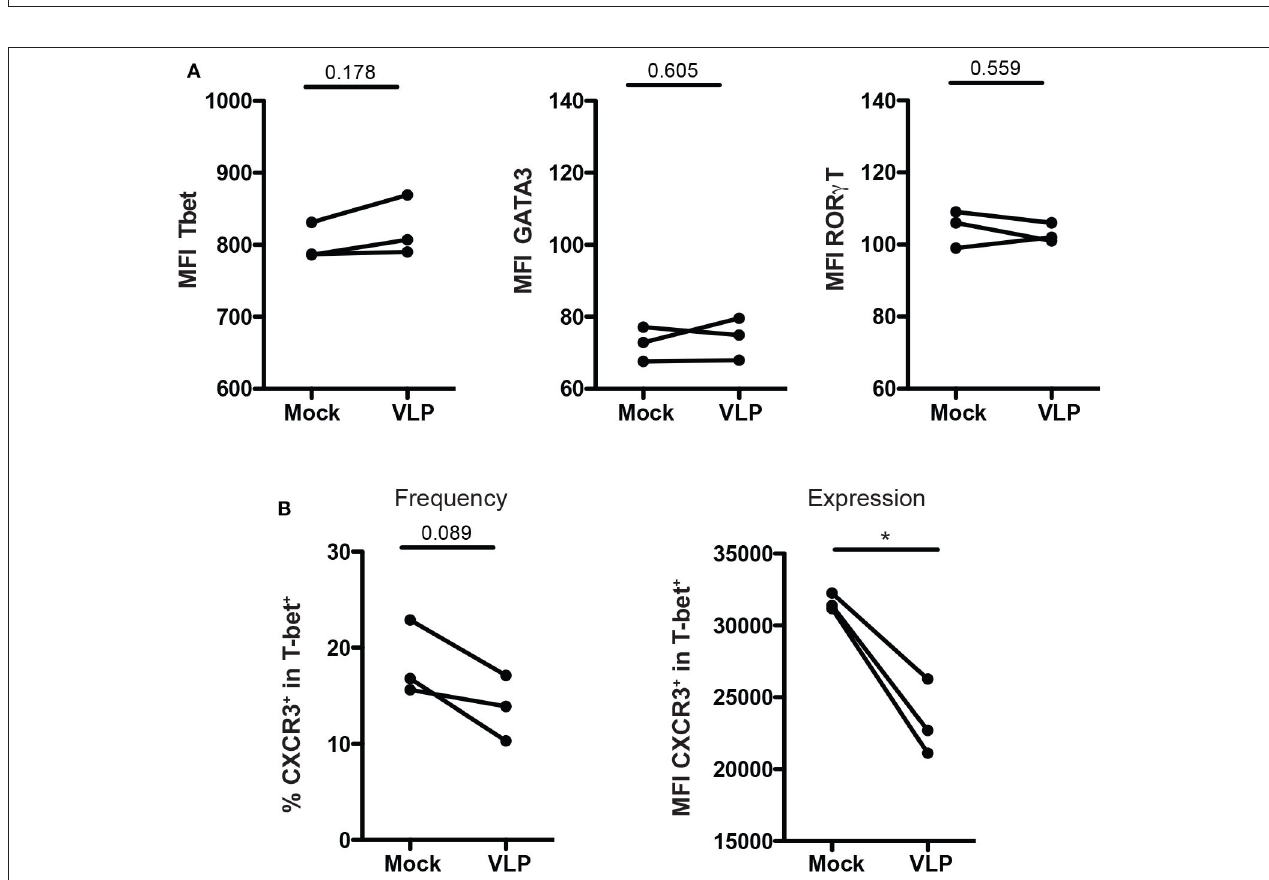
FIGURE 5 | ANDV-GP modulates CD4 + Treg phenotype by down regulating CXCR3. Three healthy donors were used to isolate CD4 + Treg from PBMCs, stimulated with VLP or no-treated (mock) and analyzed after 3 days in cell culture. (A) Mean fluorescence intensity (MFI) of T-bet, GATA3, and ROR γ t that allows the detection of Th1-like Treg, Th2-like Treg, and Th17-like Treg, respectively. (B) Frequency and expression measured by MFI of CXCR3 on the T-bet + CD4 + Treg population. Each line represents a subject sample ( n = 3). * P < 0.05, by paired Student’s t -test.